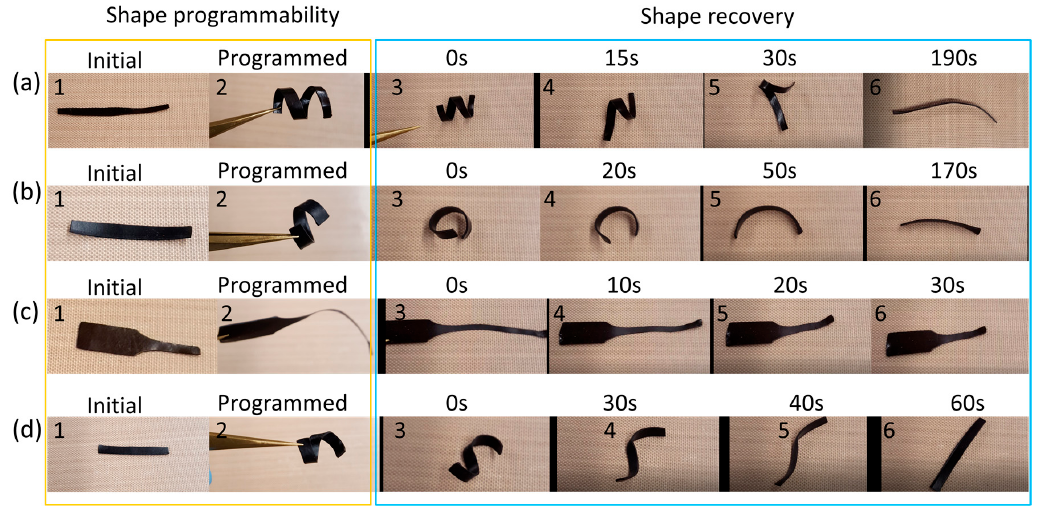
Figure 6. ( a ) Shape programmability (1 and 2) of NBR-S lignin at 70 °C and shape recovery of the sample at 70 °C after fixing. ( b ) Shape programmability (1 and 2) of NBR-I lignin at 70 °C and shape recovery of the sample at 70 °C after fixing. ( c ) Shape programmability (1 and 2) of NBR-S lignin at 150 °C and shape recovery of the sample at 150 °C after fixing. ( d ) Shape programmability (1 and 2) of NBR-I lignin at 150 °C and shape recovery of the sample at 150 °C after fixing.